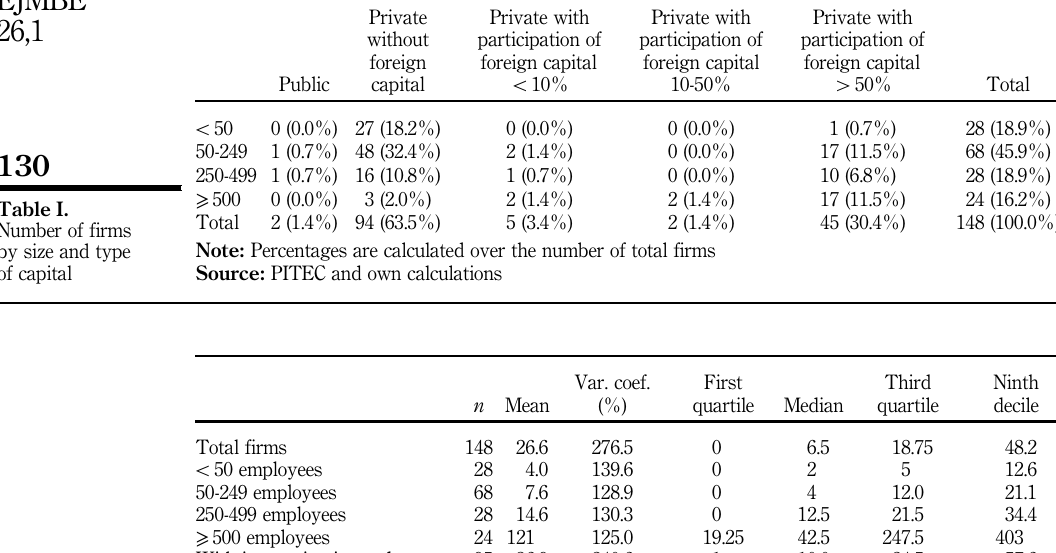
Table II. Internal staff dedicated to R&D